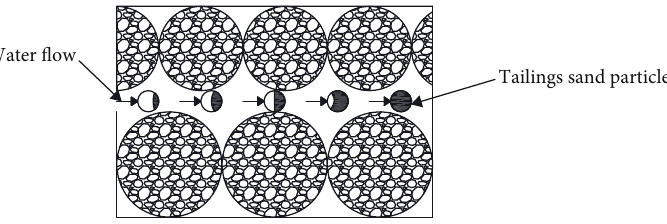
Figure 12: Diagram of tailing sand particle motion process. Table 5: Volume fraction of tailing sand under geotextile.